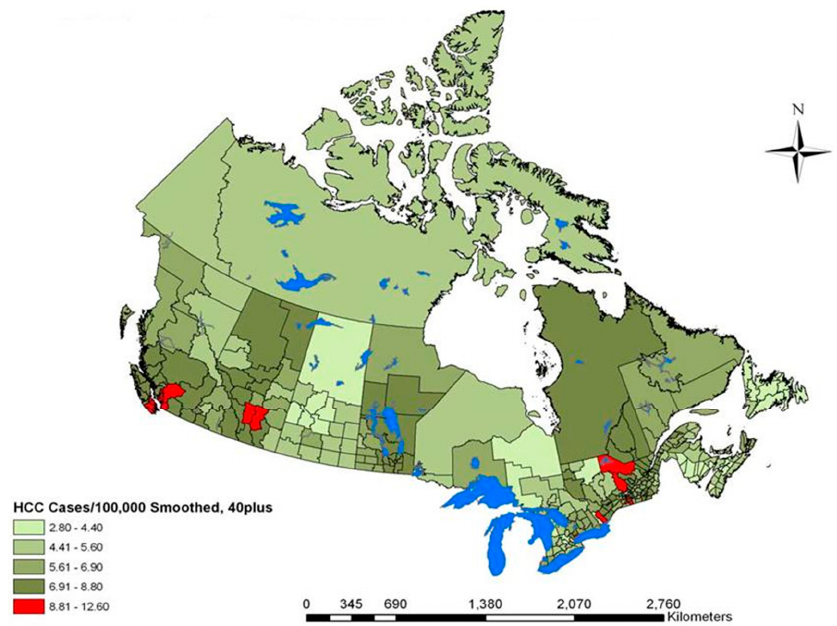
Figure 2. Canadian liver cancer cases per 100,000 within the 40+ population measured between 1996 and 2004. The map depicts the smoothed geographic distribution of cases using the five nearest spatial empirical bayes (five nearest neighbors).